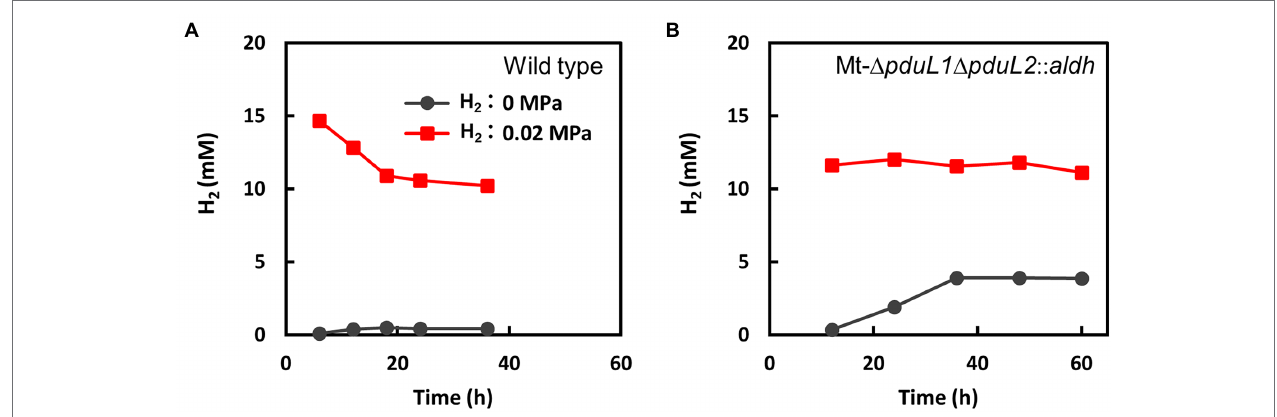
FIGURE 4 | Monitoring the consumption and evolution of H 2 by the wild-type strain (A) and the Mt- Δ pduL1 Δ pduL2 :: aldh strain (B) . The total amount of H 2 was divided by the volume of the culture medium. Black, no H 2 -supplied condition; red, H 2 -supplied condition (0.02 MPa). Error bars, which are smaller than symbols, are the SD of three biological replicates.